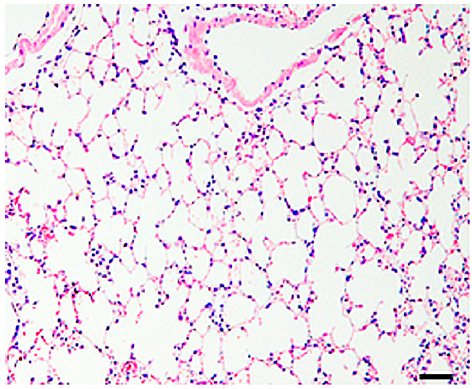
Figure 1. Histological findings of the control lungs, showing no changes. HE. Bar = 50 µm.